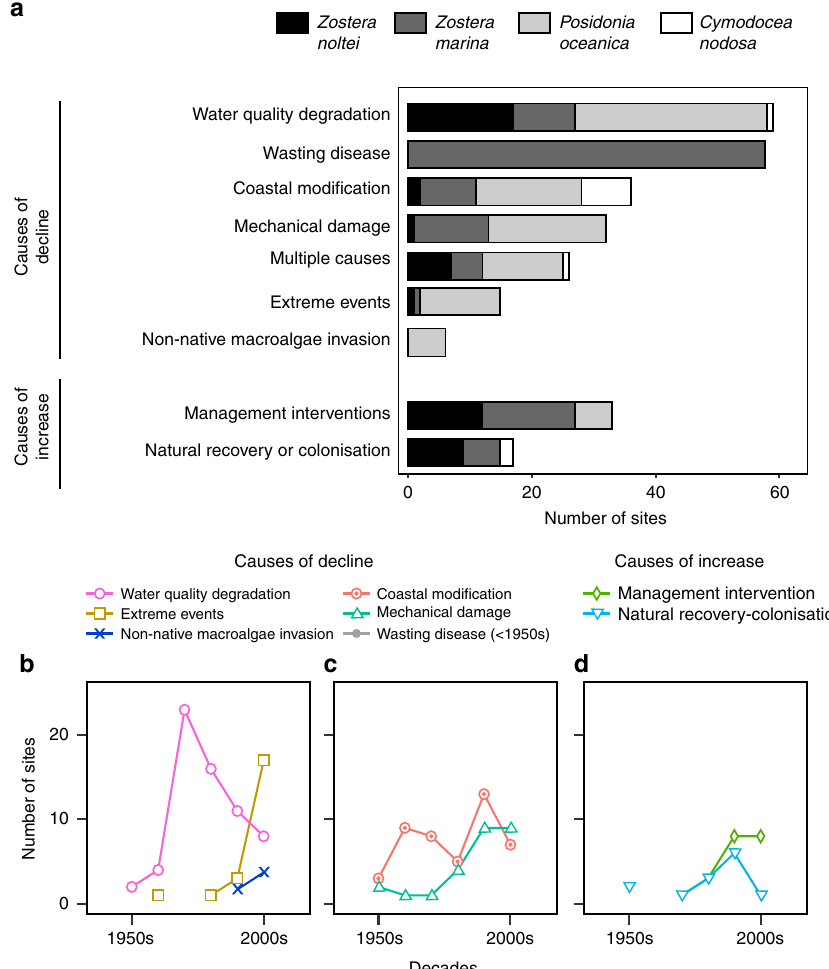
Fig. 5 Causes of change in European seagrasses. a Number of sites showing decline or increase due to different causes and decadal timeline of the number of sites that reported declines ( b – c ) and increases ( d ) from 1950s to 2000s. Only non-zero data are shown and lines connect only consecutive